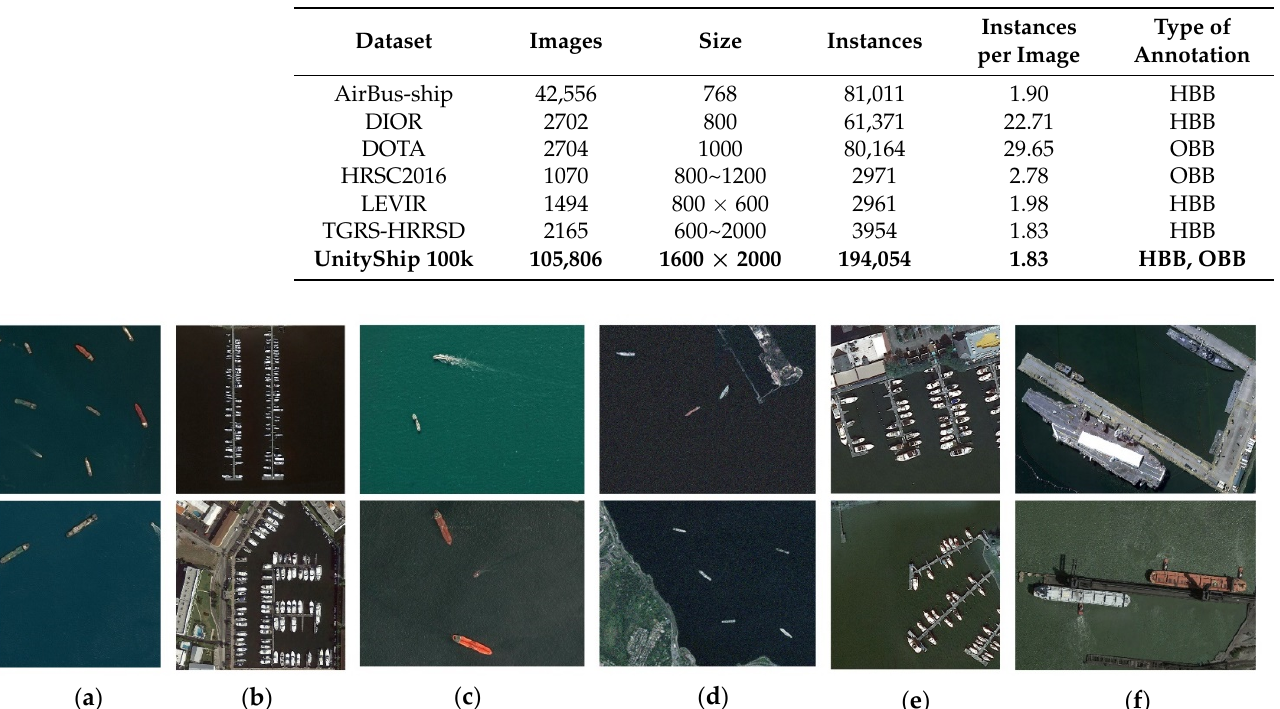
Table 3. Comparison of the real-world datasets and UnityShip synthetic datasets.